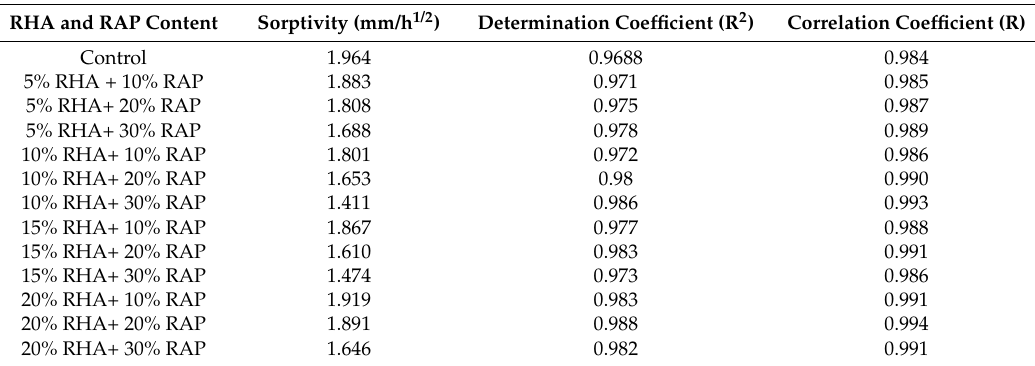
Table 12. Sorptivity by both RHA- and RAP-inclusive